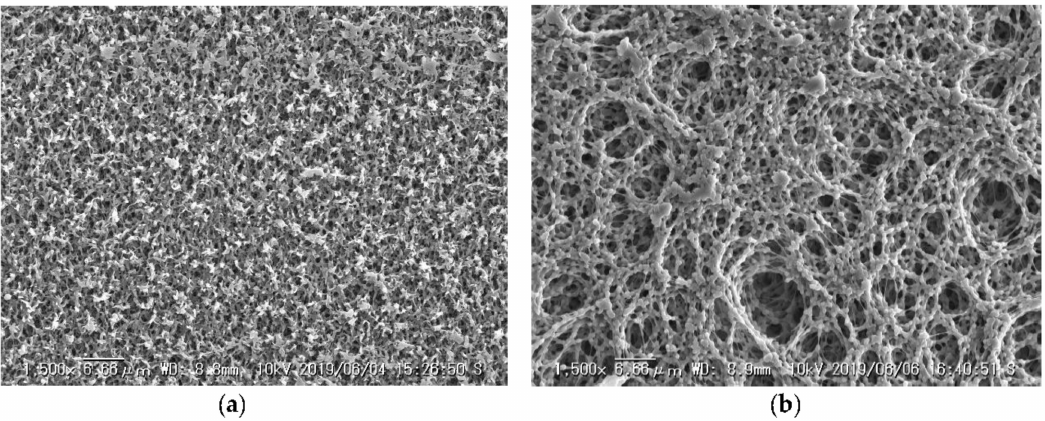
Figure 1. Scanning electron microscope (SEM) photos of virgin polyvinyl difluoride (PVDF) flat sheet membranes (1280 × 960 pixels, 1500 × , 10 kV, VE-8800, Keyence, Osaka, Japan); ( a ) pore size = 0.1 µ m, and ( b ) pore size = 0.45 µ